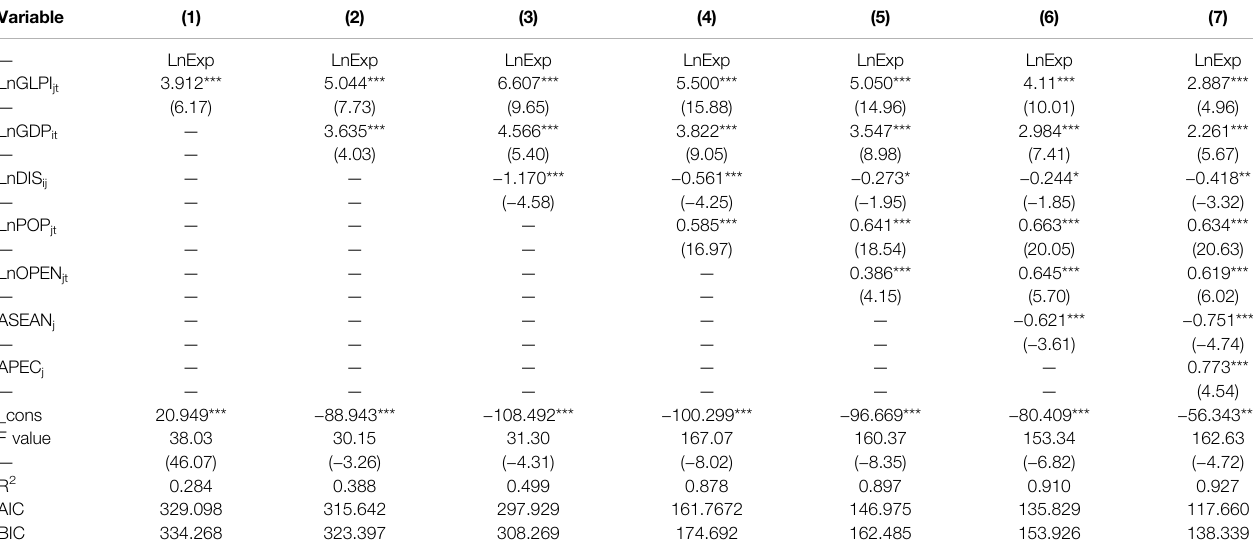
TABLE 6 | GLPI overall index regression of RCEP sample countries. Variable